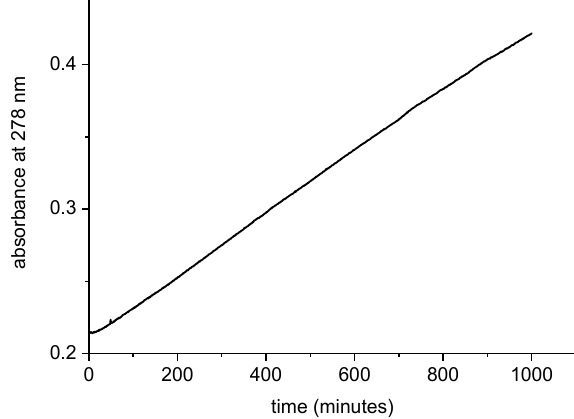
Figure 9. Absorbance at 278 nm recorded during the homocoupling reaction of 150 μ M 1 in pH 9.1 borate buffer (10 mM) in the presence of 1.8 μ M Na 2 PdCl 4 at 30 °C.